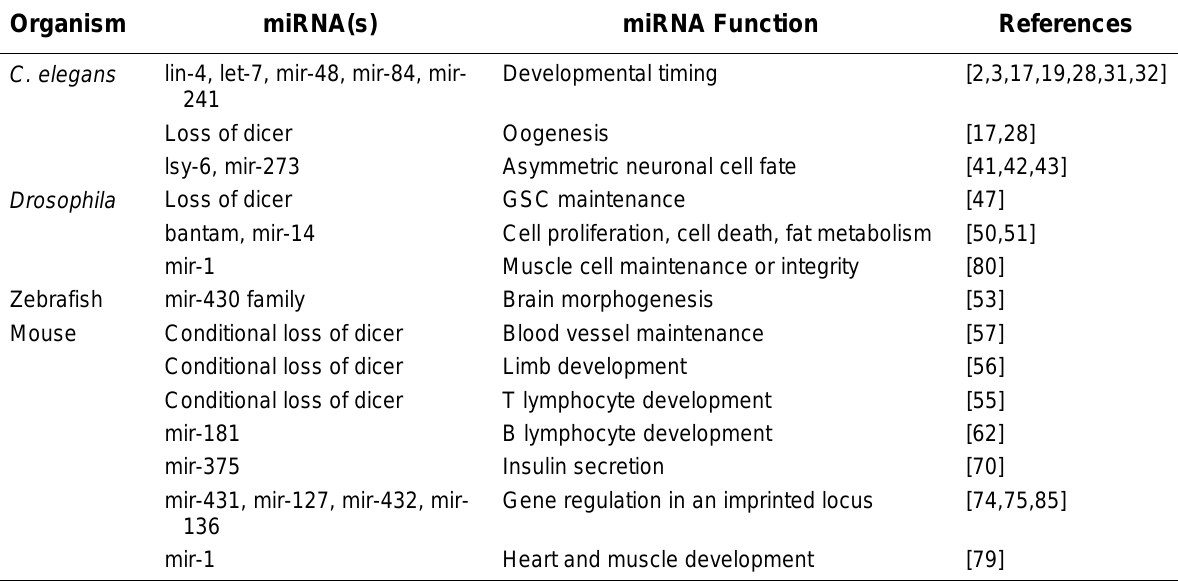
miRNA Functions in C. elegans, Drosophila , Zebrafish, and Mouse